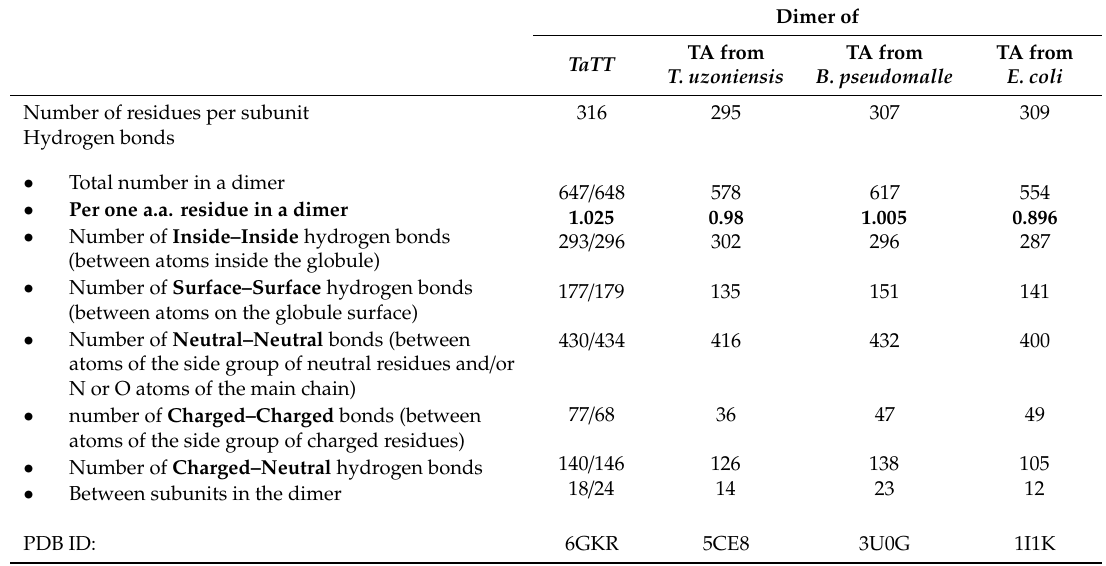
Table A1. Analysis of hydrogen bonds in functional dimers of TaTT and the counterparts: transaminase (TA) from Thermoproteus uzoniensis ( Toptm in the standard assay is 95 ◦ C [42]), TA from Burkholderia pseudomallei ( Toptm is unknown, the organism grows optimally at 40 ◦ C) and TA from Escherichia coli ( Toptm in the standard assay is 37 ◦ C [43]). Two values for the TaTT dimer correspond to two dimers composed of di ff erent subunits in the 6GKR model.